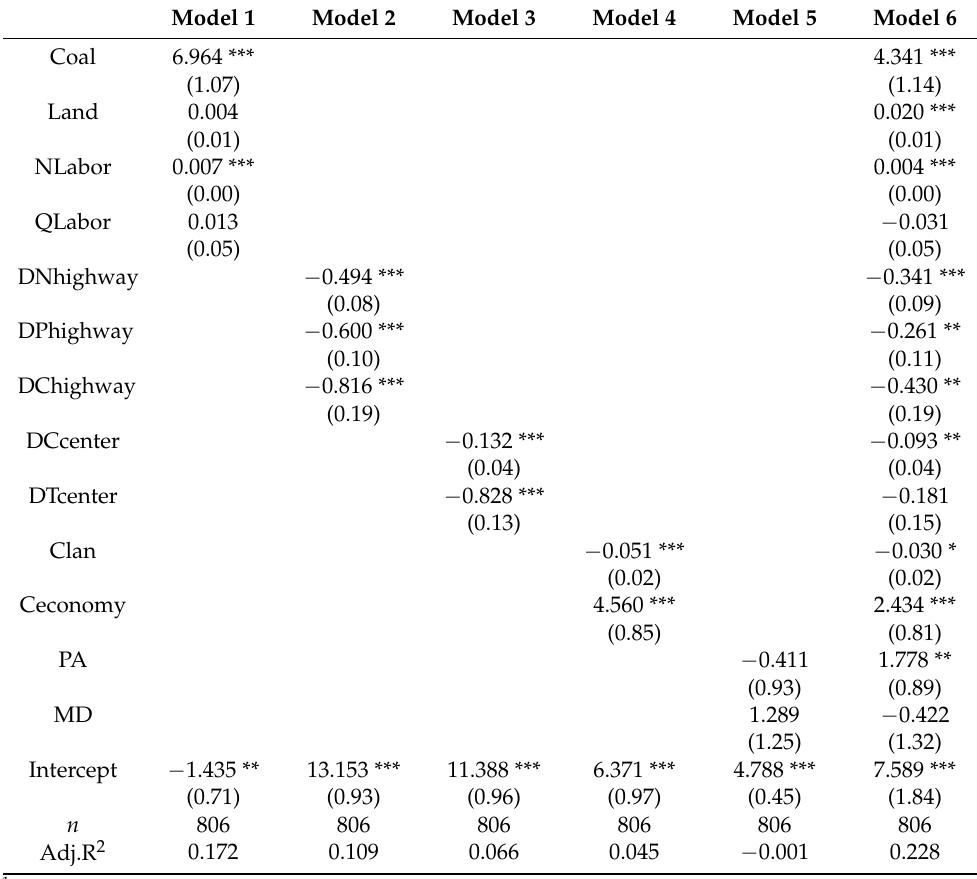
Table 5. Results for multiple liner regression models 1